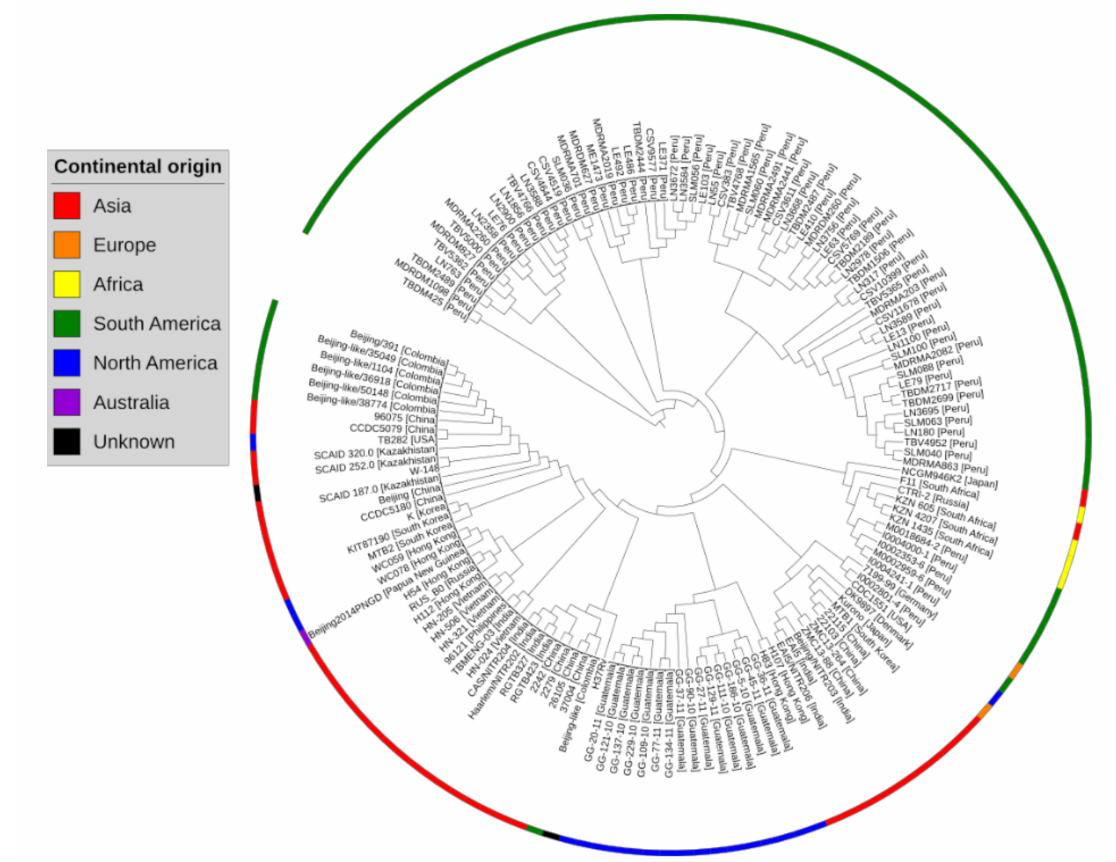
Figure 2. Pan-phylogeny tree of 150 complete genomes of Mycobacterium tuberculosis . Colored strips show the continental origin of strains. Overall, the strains originating from di ff erent geographical regions of the World clustered into di ff erent clades. This pan-phylogeny has been constructed based on accessory gene presence / absence data in di ff erent